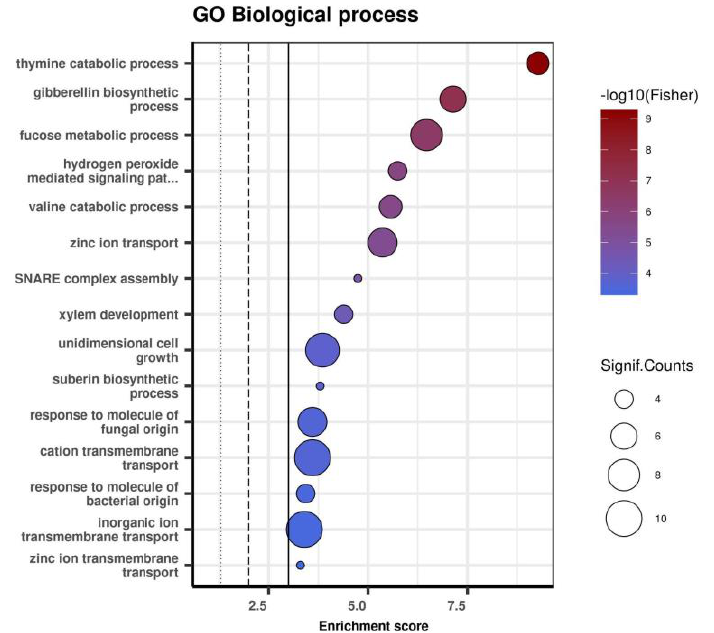
Figure 4. GO biological process terms enriched in the 364 genes physically close to the associated markers (only the first 15 major terms are shown).